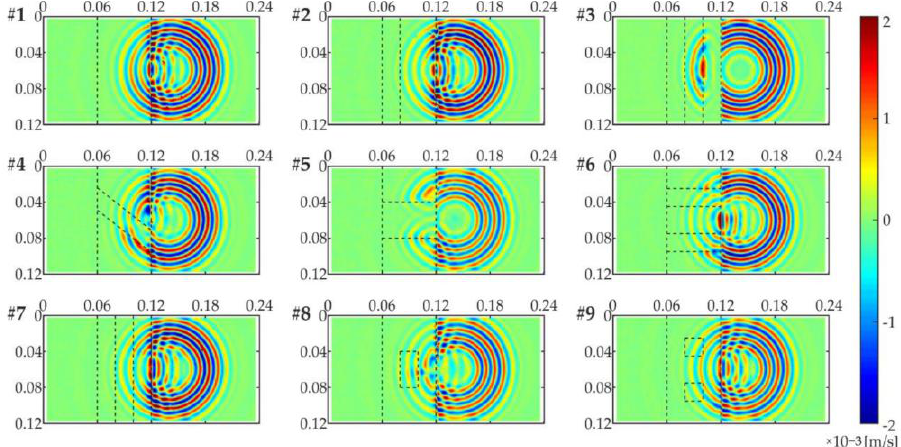
Figure 7. Scanning laser Doppler vibrometry (SLDV) maps of considered joints at the time instance 27.7 µ s (dimensions of the joint are given in meters; the adhesive was 0.06–0.12